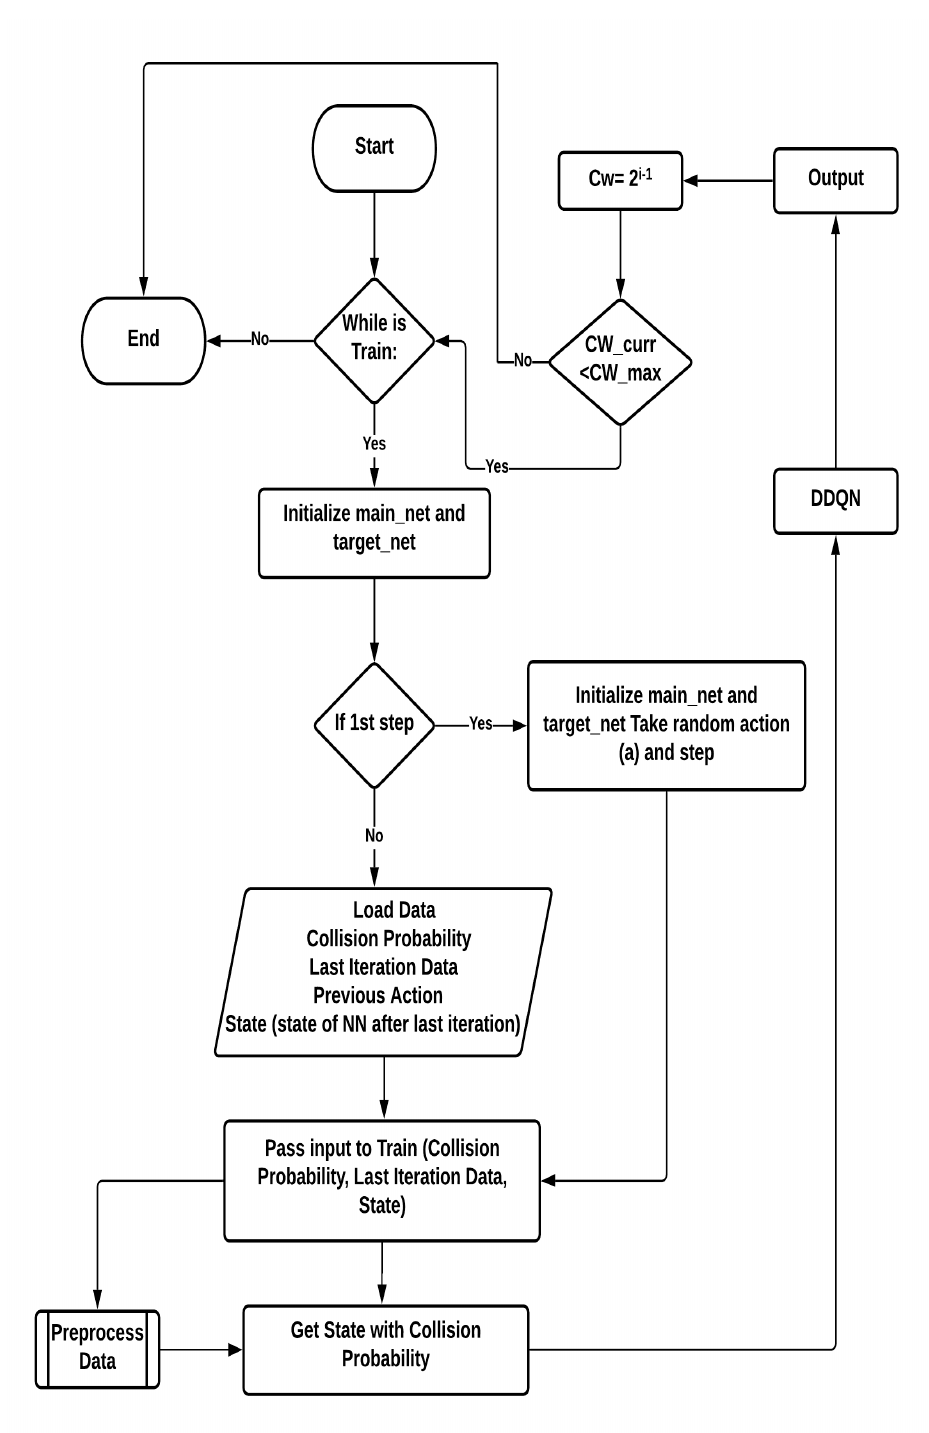
Figure 3. DCWO Flow